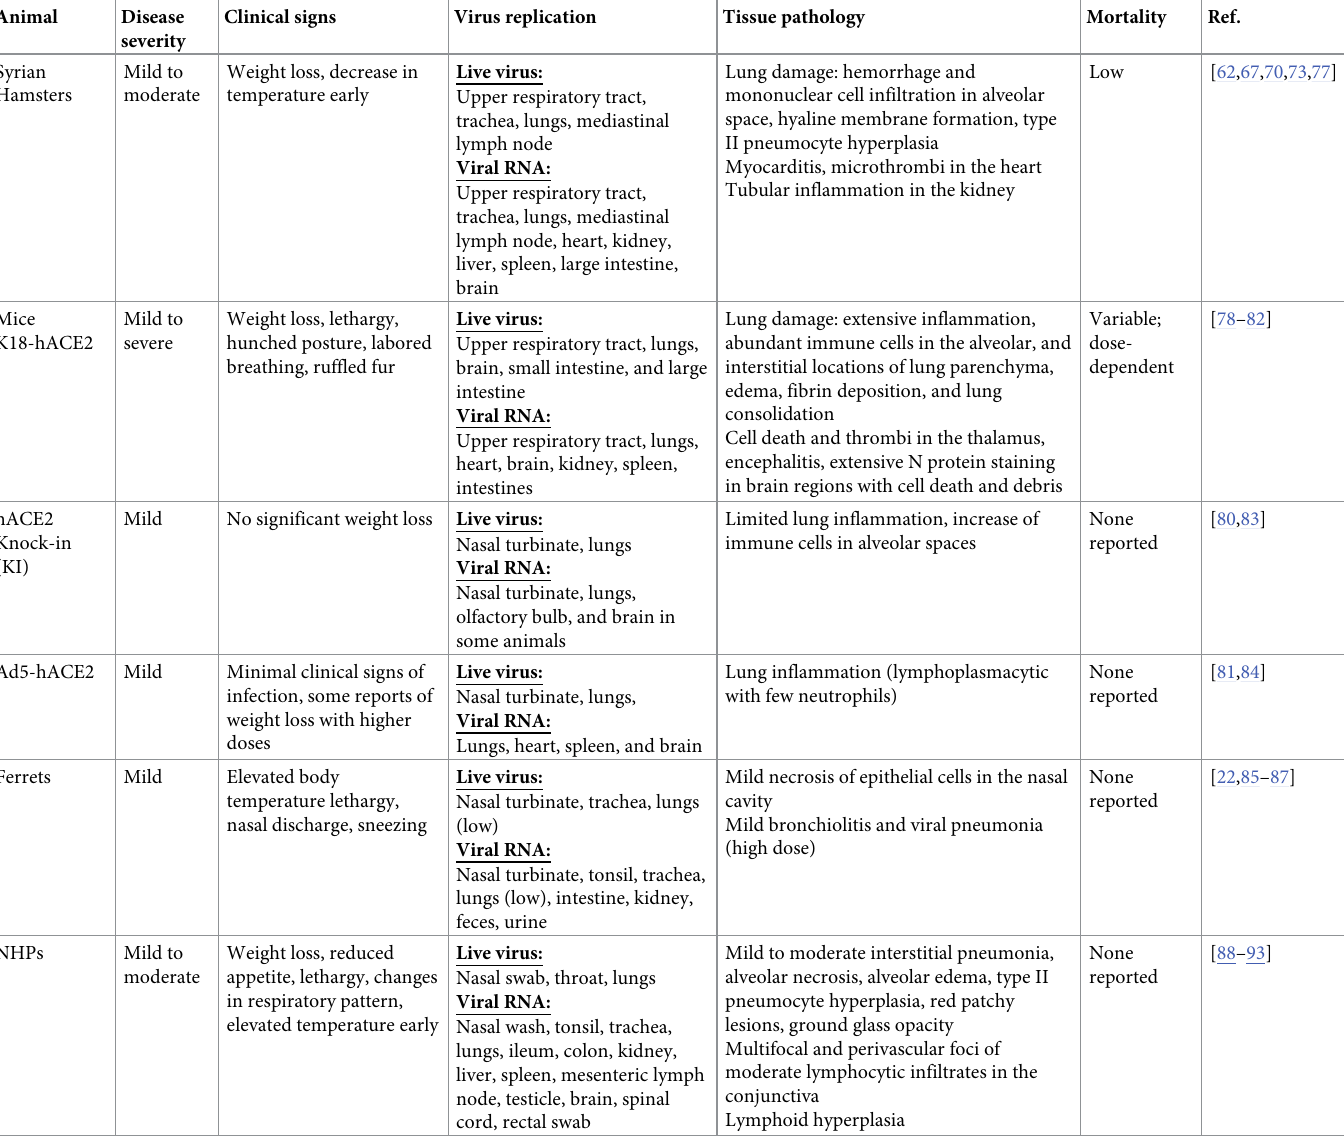
Table 1. Overview of commonly utilized SARS-CoV-2 animal models. Animal Disease